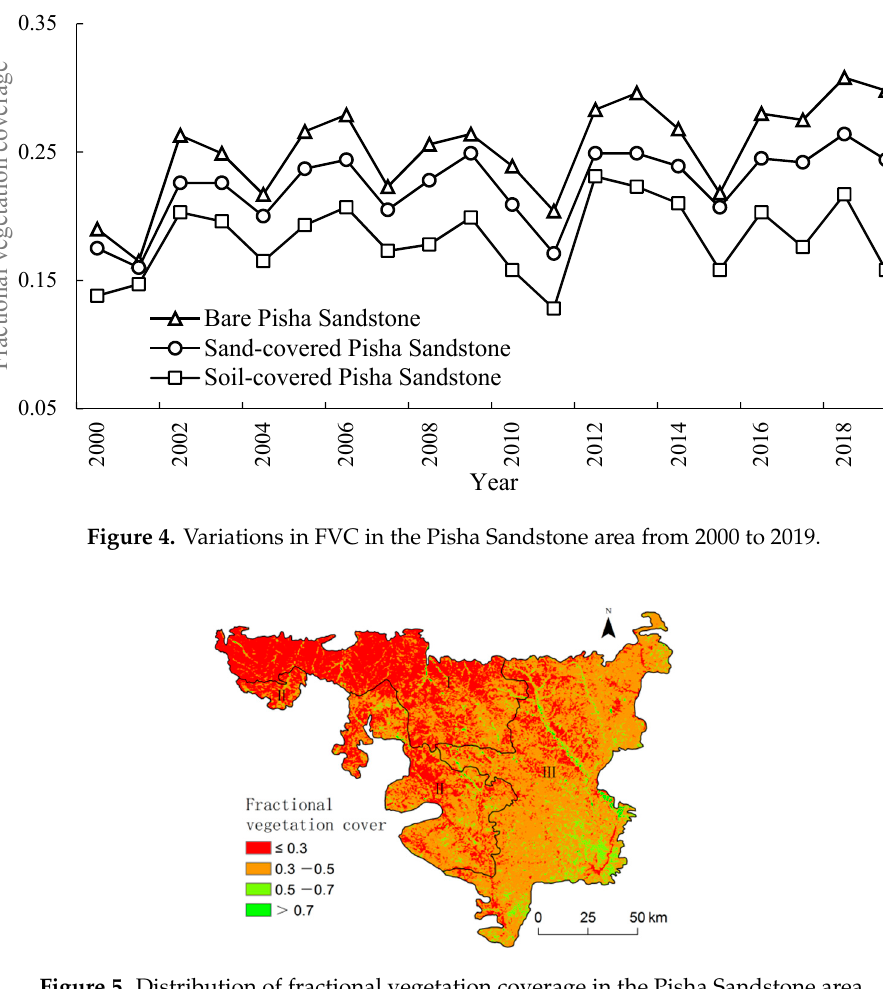
Figure 5. Distribution of fractional vegetation coverage in the Pisha Sandstone area.